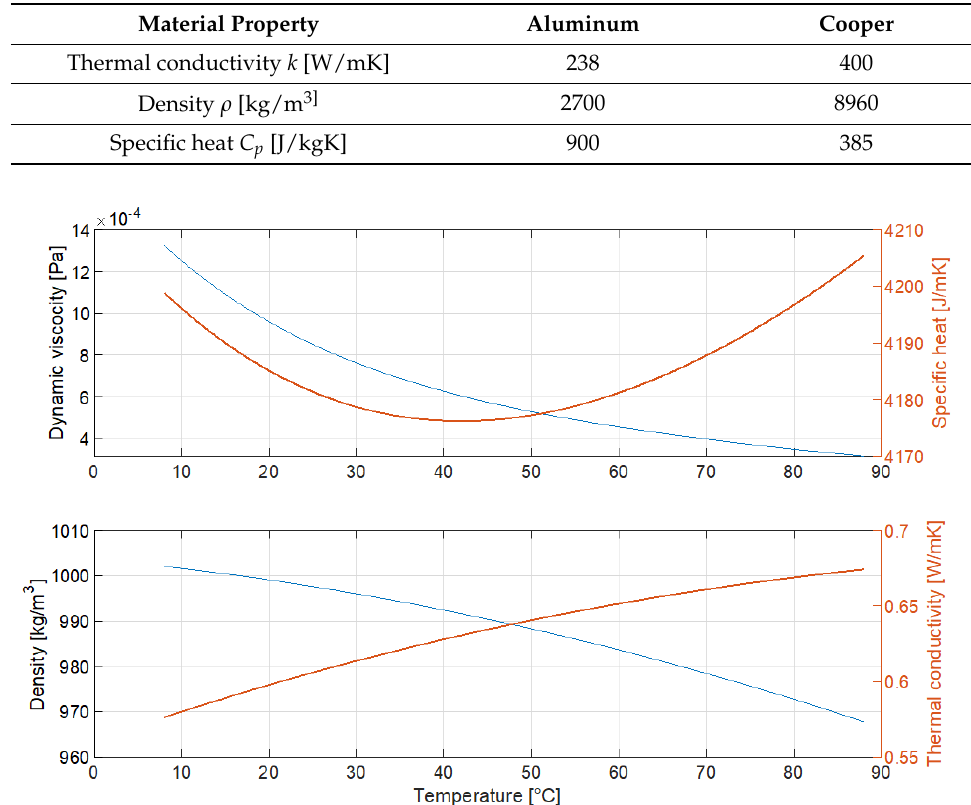
Figure 8. Water thermal properties.